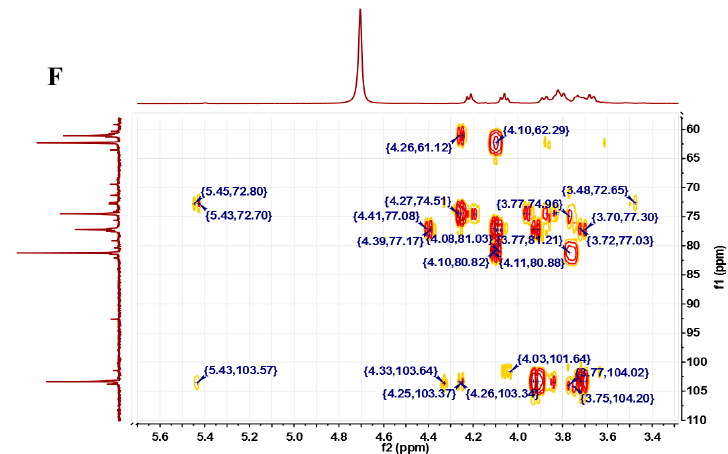
Figure 3. NMR spectra of PD1-1: ( A ) 1H; ( B ) 13C; ( C ) DEPT135; ( D ) 1H–1H COSY; ( E ) HSQC; and ( F ) HMBC.